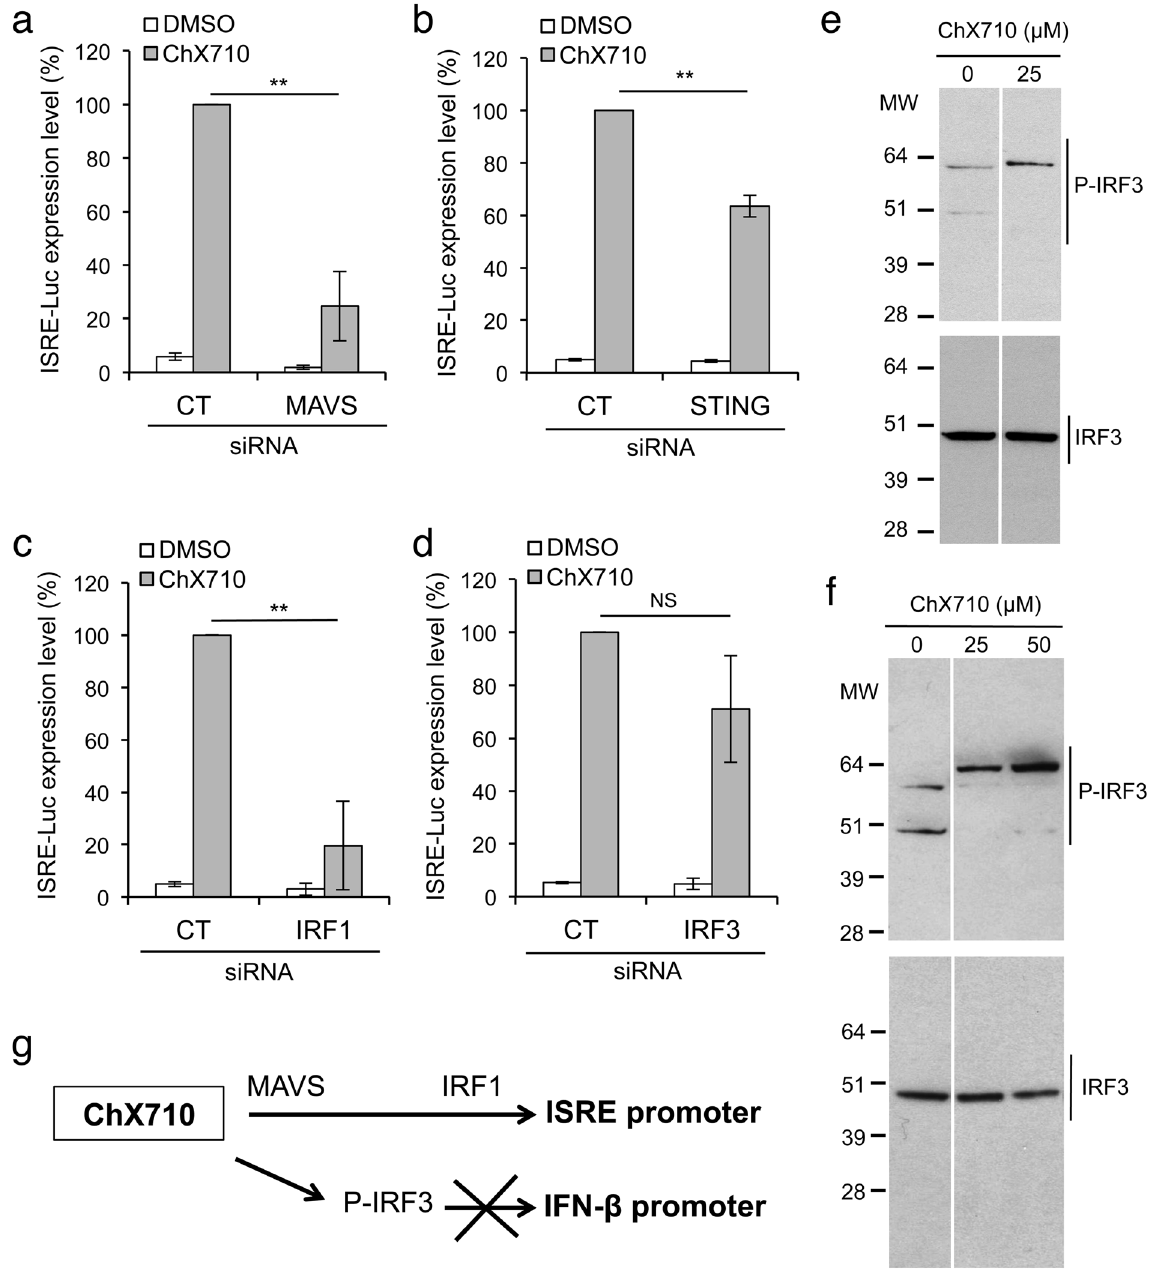
Figure 5. ISRE induction by ChX710 is dependent on MAVS and IRF1. ( a ) MAVS was silenced by siRNA transfection in ISRE-luciferase reporter cells. After 48 hours of cultures, cells were stimulated with ChX710. After 24 hours of incubation, luciferase induction was determined. ( b ) Same experiment as ( a ) using STING- specific siRNA. ( c ) Same experiment as ( a ) using IRF1-specific siRNA. ( d ) Same experiment as ( a ) using IRF3-specific siRNA. ( e,f ) IRF3 phosphorylation was determined by western-blot in HEK-293T ( e ) or A549 cells ( f ) treated for 24 hours with DMSO alone or ChX710 at 25 μ M or 50 μ M. ( g ) Schematic model of the signaling pathways induced by ChX710. IRF3 phosphorylation is induced, but this is insufficient to activate IFN- β expression. Data represent means ± SD of three independent experiments, except for ( e ) and ( f ) that corresponds to representative results. ** P < 0.01 as calculated by Student’s t